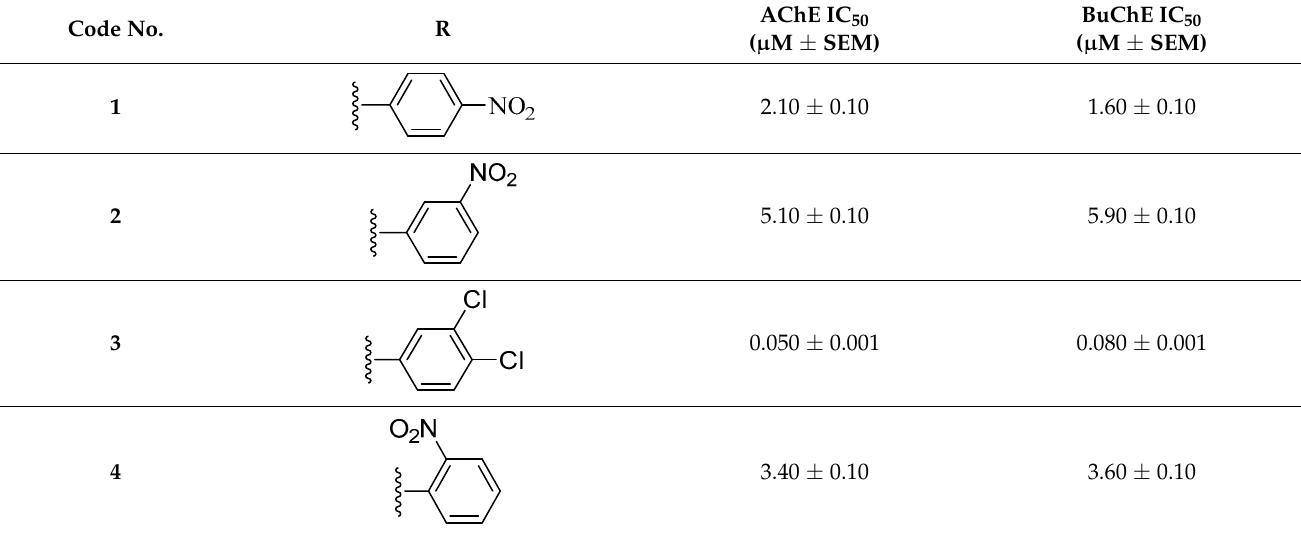
Table 4. Structure, acetylcholinesterase and butyrylcholinesterase inhibition activity of benzimid- azole analogs. Code No.